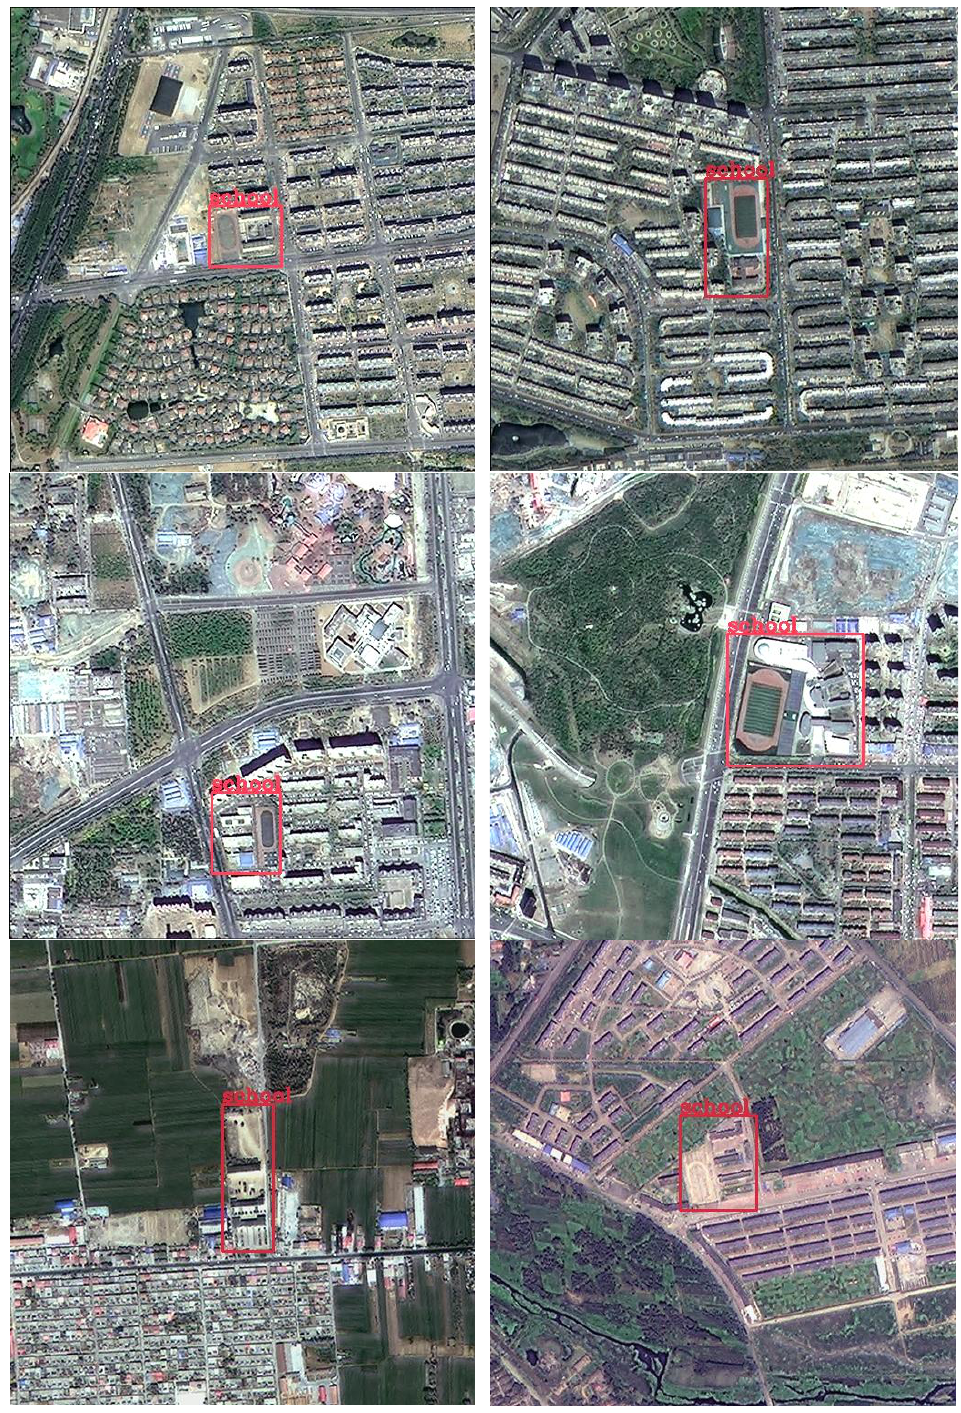
Figure 1. Samples of PSSs in different regions. The previous four images show the PSSs in urban areas. The last two images show the PSSs in remote regions.